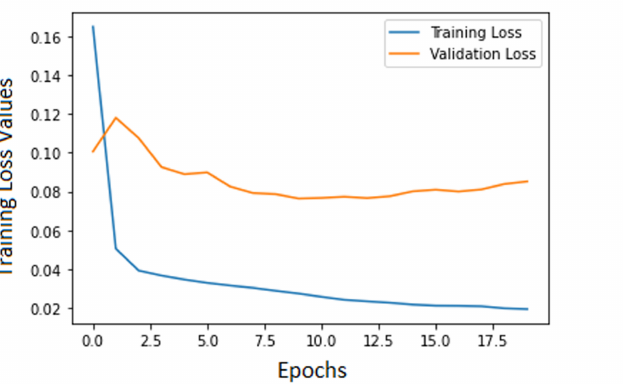
Figure 10. The difference between training and validation loss in Case 1.